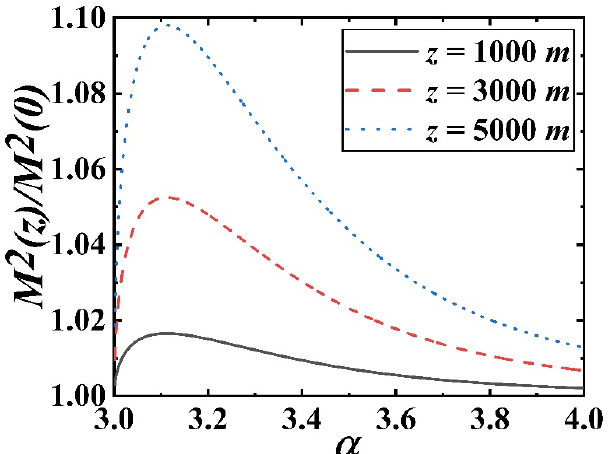
and . From Figure 3, it is seen that the M increases by in ‐ L . Obviously, a worse beam quality is obtained by a larger creasing the outer scale, Figure 2. Dimensionless quantity M 2 ( z ) / M 2 ( 0 ) of a partially coherent Airy beam in non-Kolmogorov Figure 2. Dimensionless quantity     2 2 0 M z M of a partially coherent Airy beam in non ‐ Kol ‐ 0 outer scale of non ‐ Kolmogorov turbulence. turbulence versus the generalized exponent parameter for different z . mogorov turbulence versus the generalized exponent parameter for different z .     2 2 0 M M L The results shown in Figure 3 excluded the in four different 0 with   2 0 M M . From Figure 3, it is seen that the increases by in ‐ L . Obviously, a worse beam quality is obtained by a larger creasing the outer scale, 0 outer scale of non ‐ Kolmogorov turbulence.